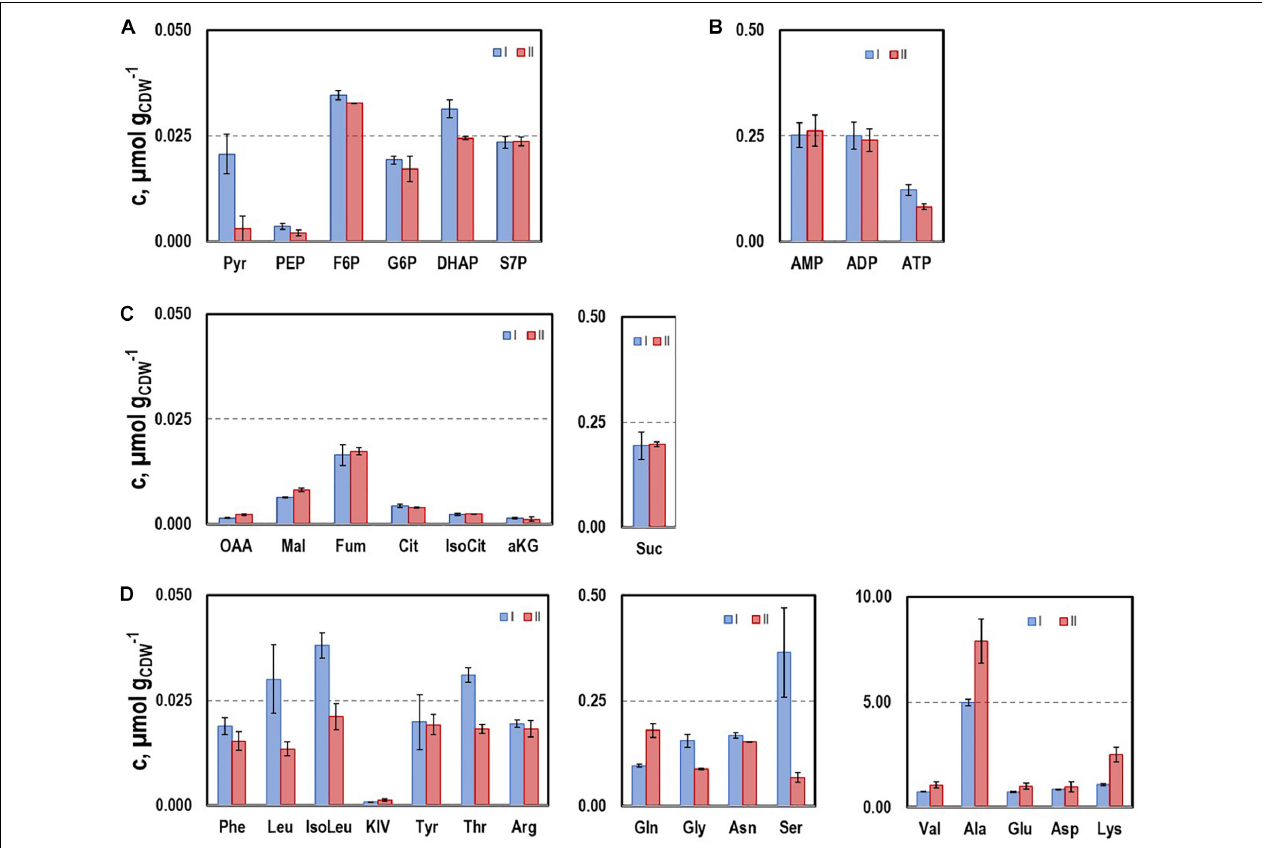
FIGURE 3 | Selected intracellular pools representing Emden-Meyerhof-Parnas and the pentose-phoshate pathway (A) , energy metabolism (B) , citrate cycle (C) , and amino acids (D) . Samples were taken during growth phases I and II cultivating CLJU[WT] on syngas in a stirred tank. Error bars are derived from technical replicates.